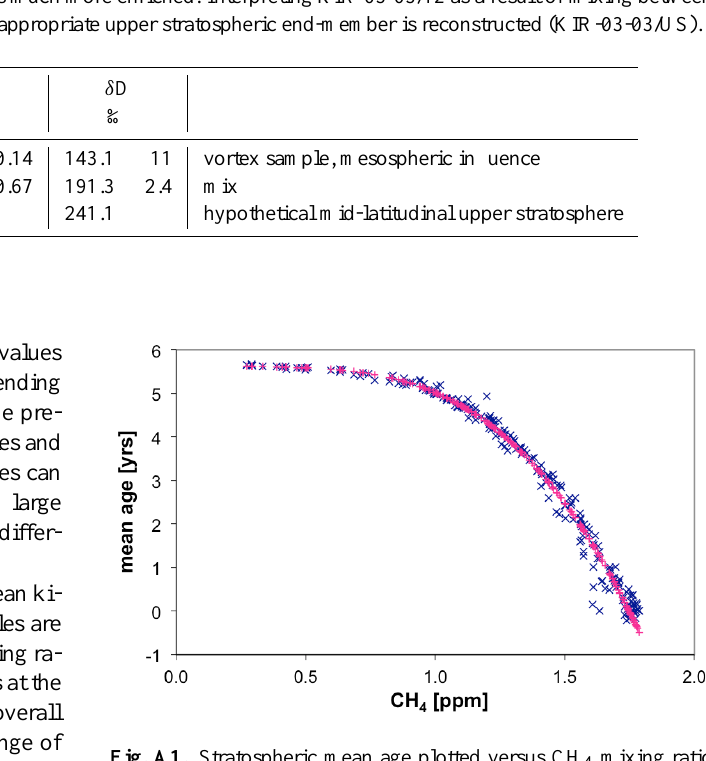
Figure 8: stratospheric mean age plotted versus CH 4 mixing ratio (red,”+”). The original age 847 Fig. A1. Stratospheric mean age plotted versus CH 4 mixing ratio (red, “+”). The original age inferred from the N 2 O mixing ratio is inferred from the N 2 O mixing ratio is shown in blue (“-”). 848 shown in blue (“ × 849